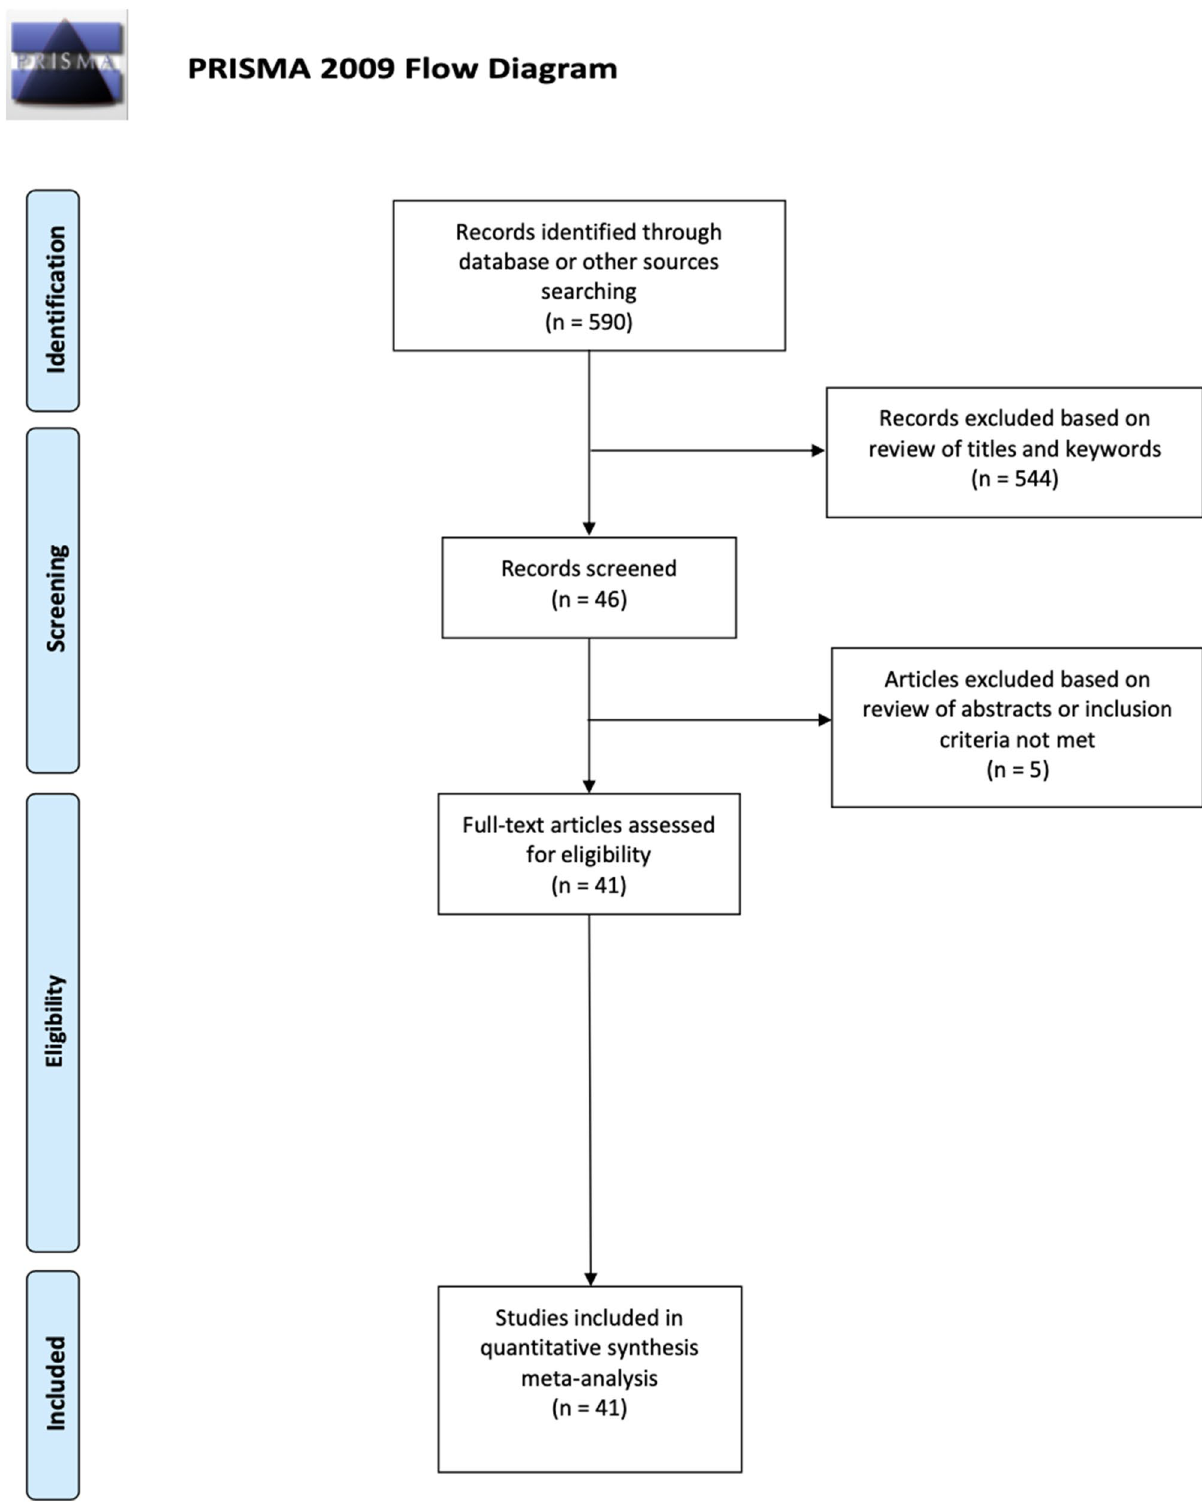
Figure 1. Flowchart illustrating study selection, review strategy and data extraction, retrieved from: http:// prisma- state ment. org/ docum ents/ PRISMA% 202009% 20flow% 20dia gram.